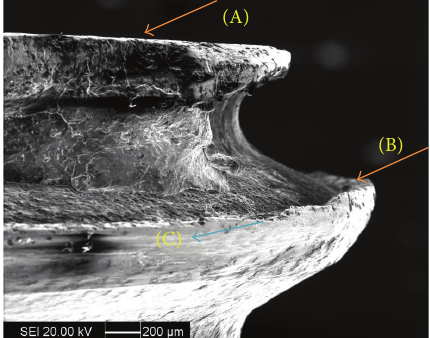
Figure 37: SEM image of the FSP tool after 25150 mm of processing: (A) crack, (B) adhered aluminum, and (C) friction